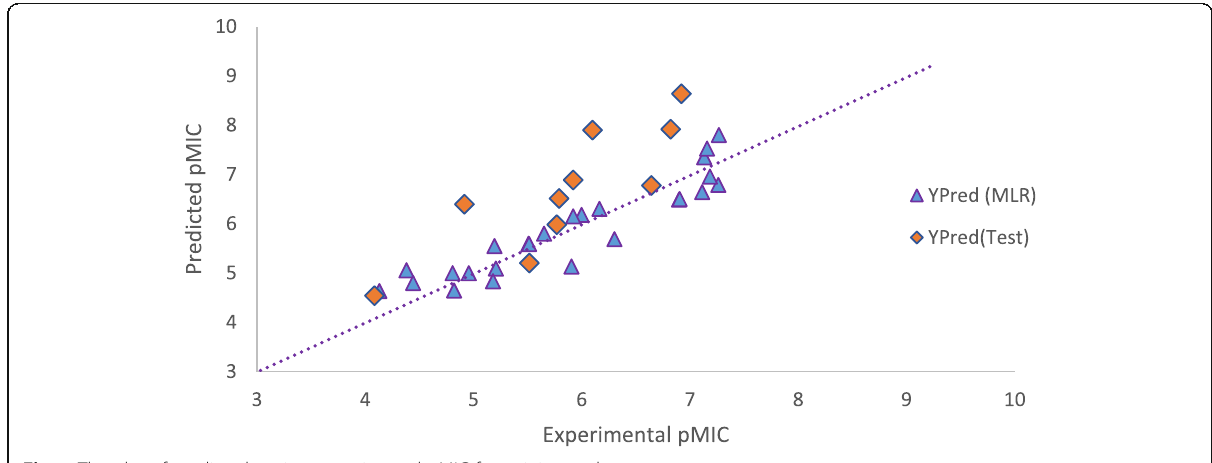
Fig. 1 The plot of predicted against experimental pMIC for training and test